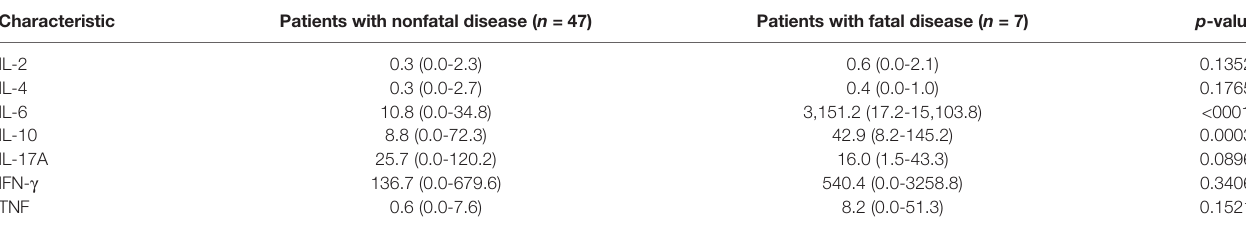
TABLE 2 | Comparison of cytokine concentrations between patients with nonfatal and fatal disease a .